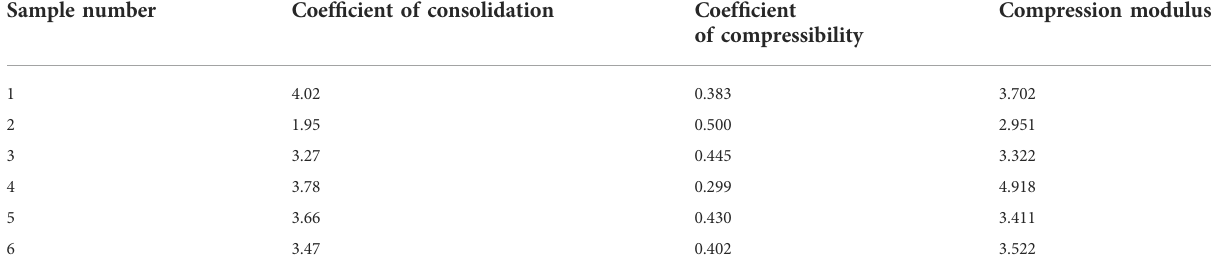
TABLE 2 Consolidation test parameters. Sample